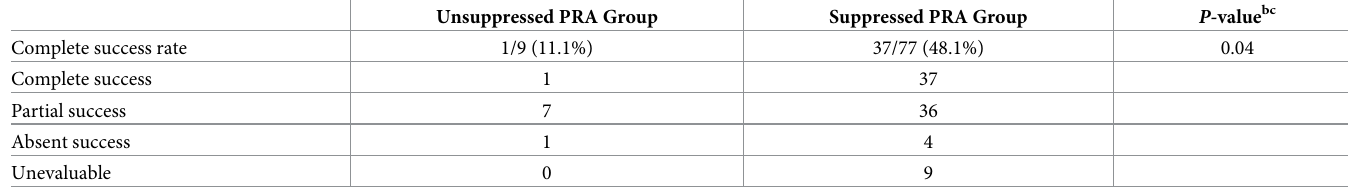
Table 5. Clinical outcomes 1 year after the surgery in the unsuppressed and suppressed PRA groups a